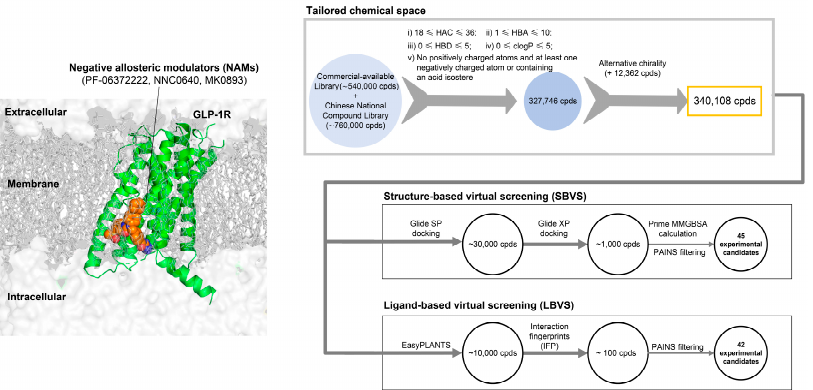
Figure 1. Schematic representation of the GLP-1R allosteric modulator discovery process with structure-based virtual screening (SBVS) and ligand-based virtual screening (LBVS). By analyzing the reported allosteric modulators (PF-0637222, NNC0640 and MK0893), a tailored library consisting of 340,108 compounds underwent the following two different protocols: structure- and ligand-based virtual screening.